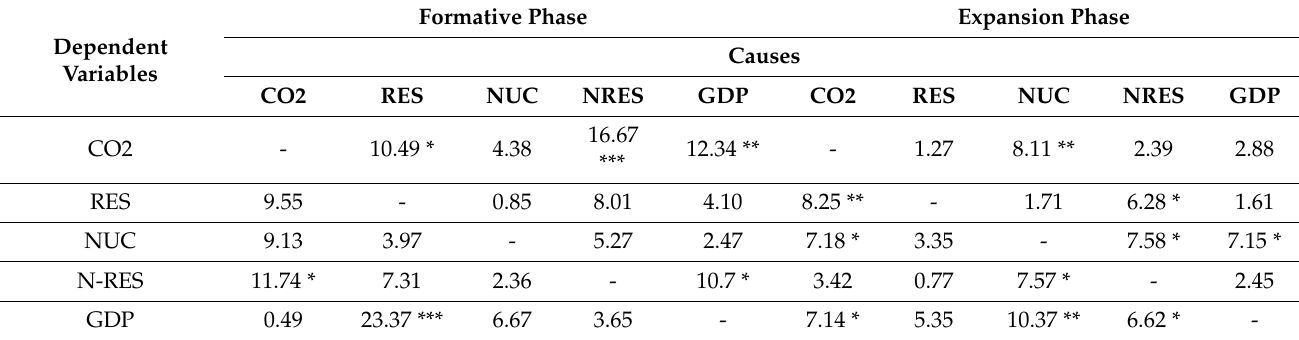
Table A2. Granger causality test results and residual